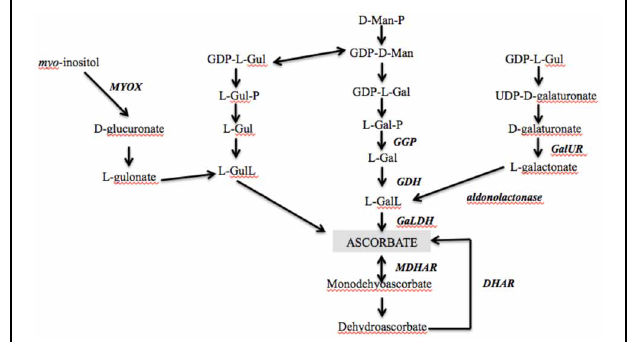
FIGURE A1 | The proposed biosynthetic pathways for ascorbate in plants. L-Gal, L-galactose; L-GalL, l-galactono-1,4-lactone; -LGul, L-gulose; L-GuL, L-gulono-1,4-lactone; D-Man, d-mannose; UDP, uridine diphosphate; GGP , GDP-L-galactose phosphorylase; GDH , L-galactose dehydrogenase; GaLDH , L-galactono-1, 4-lactone dehydrogenase; GalUR , D-galacturonate reductase MYOX , myo -inositol oxidase; MDHAR , monodehydroascorbate reductase ; DHAR , dehydroascorbate